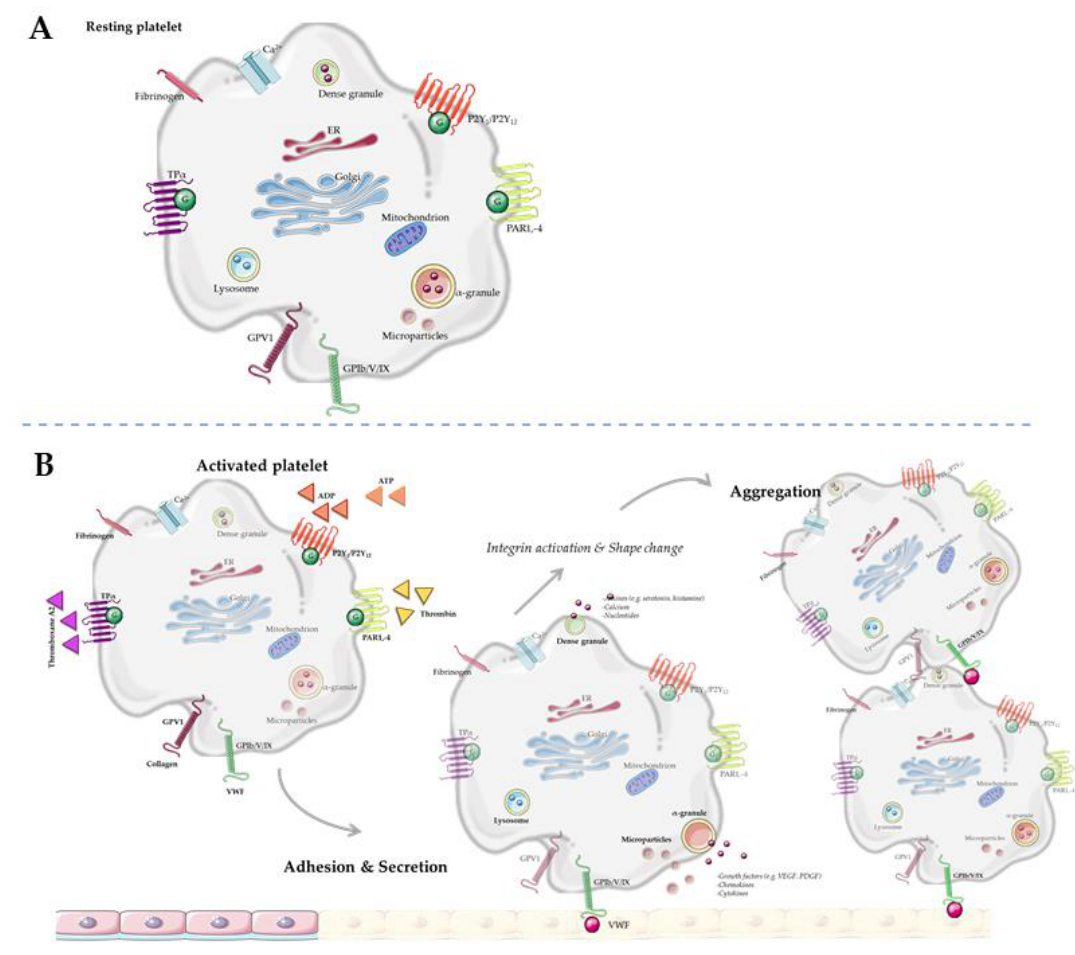
Figure 1. Schematic representation of platelet activation. ( A ) Resting platelet. ( B ) Platelet activation, adhesion and aggregation.